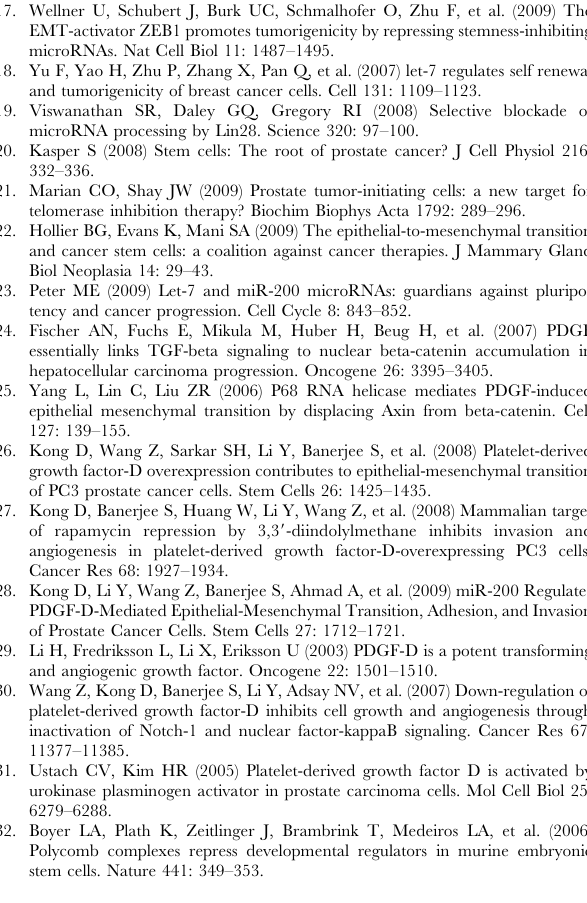
Table S1 Fold change in EMT-associated genes induced by over-expression of PDGF-D in PC3 cells.